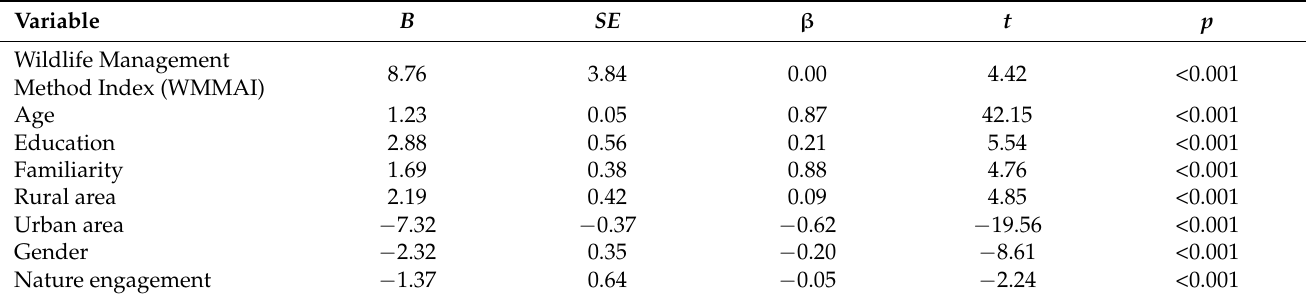
Table 6. Regression analysis of Wildlife Management Method Attitude Index